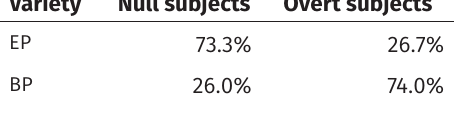
Table 2: Percentages of null and overt subjects in EP and BP.